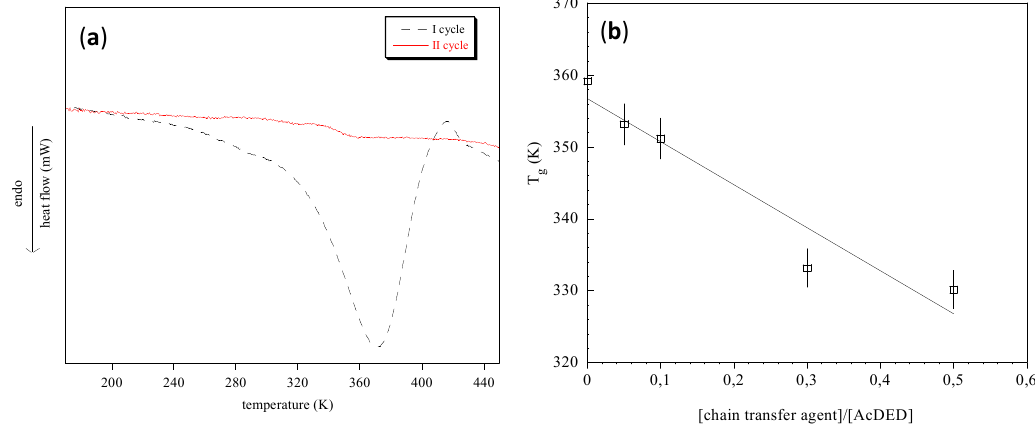
Figure 2. pAcDED thermograms related to the first and second heating cycle ( a ); T=0 dependence of polymer glass transition temperature ( T ) on the chain transfer g agent/[AcDED] ratio ( b ). The T values were determined by the first derivative of the g curve obtained in the second heating